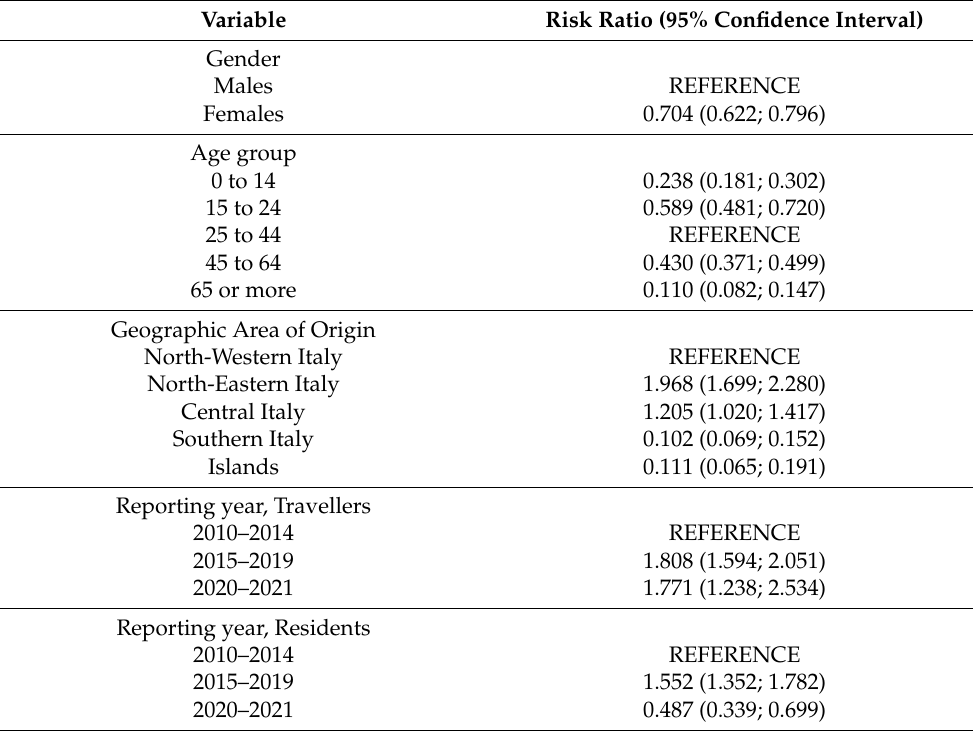
Table 3. Distribution of Italian cases of dengue by geographic area of residence and sex. A total of 1043 out cases were included in the